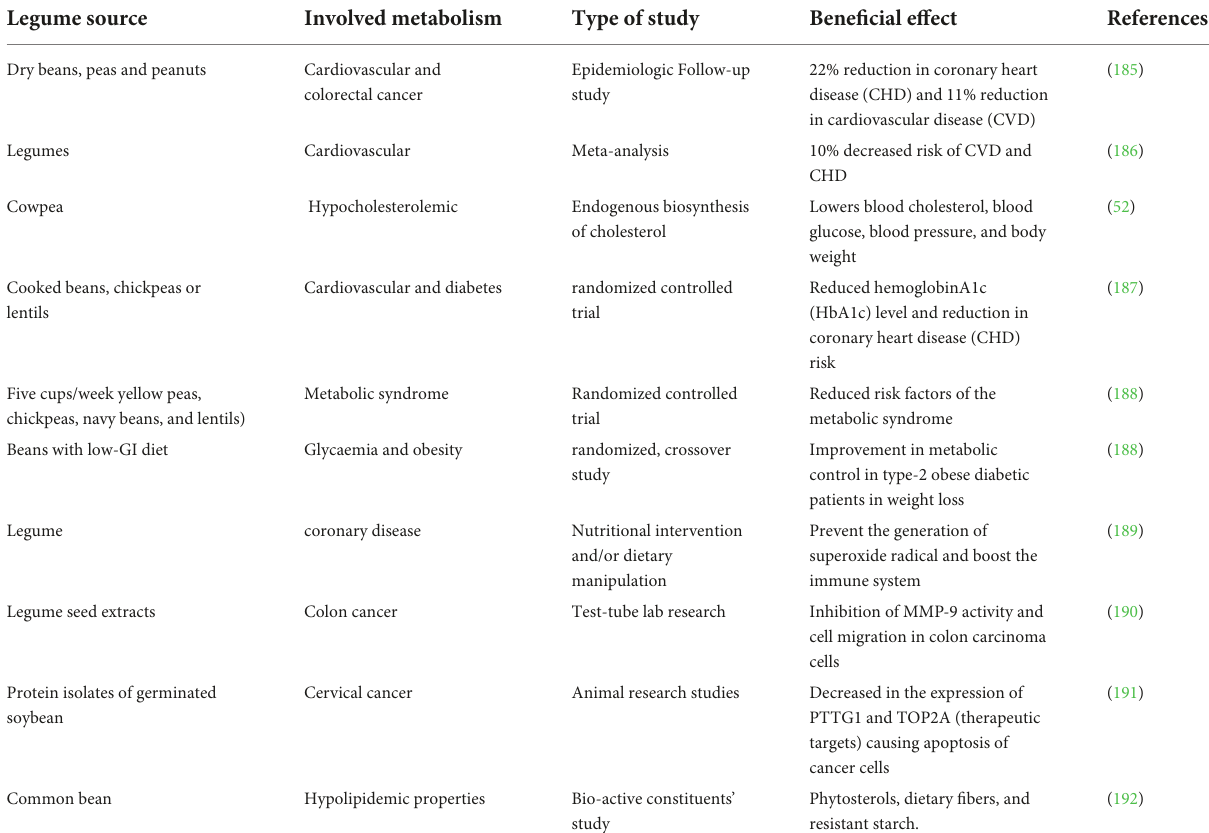
TABLE 5 Health benefits of various legume